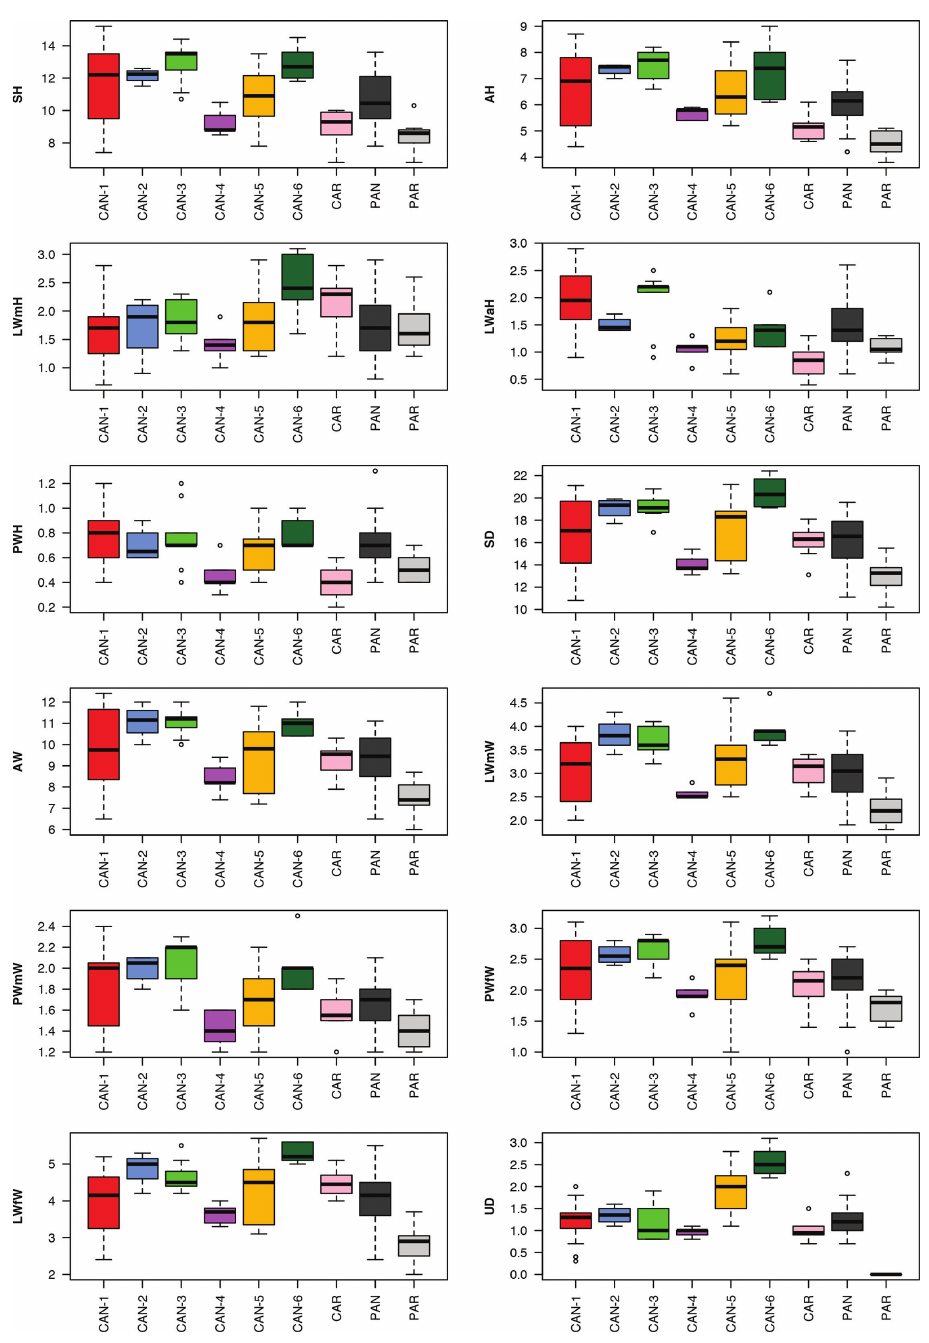
Figure 34. Box plots for shell characters of the nine Monacha species or molecular lineages investigated. The lower and upper limits of the rectangular boxes indicate the 25 th to 75 th percentile range, and the horizontal line within the boxes is the median (50 th